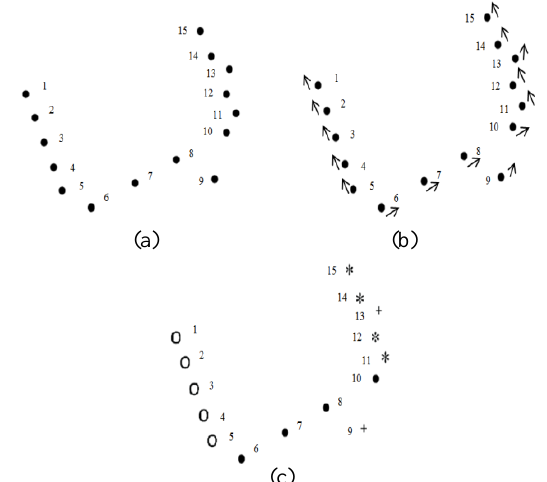
Figure 2. Breaking a scan line into different scan profiles: (a) points on a scan line; (b) direction vectors of each point and (c) the final outcome (different symbols indicate different scan